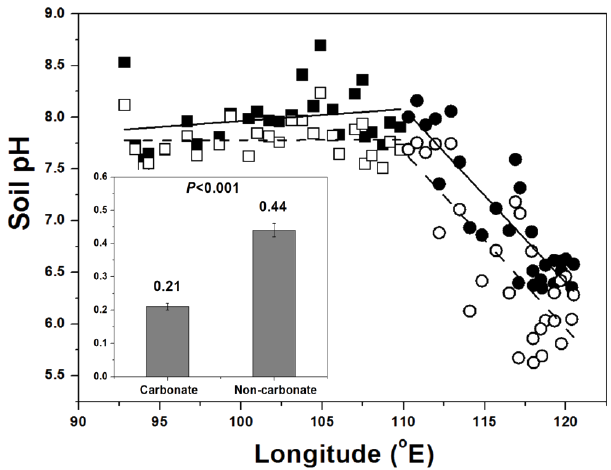
Figure 1. Acidification of grassland soils upon acid addition (16mmol H + kg − 1 soil added) to carbonate-containing soils (squares) and the non-carbonate-containing soils (circles) collected from the 3600km long transect. The empty symbols denote back- ground soil pH as control, while the filled symbols represent soil pH value after acidification. Mean changes in pH values for both carbonate-containing and non-carbonate-containing soils are shown in the inset. The solid line and dashed line represent the mean pH values of controls and acid-treated soils across the transect, respec-